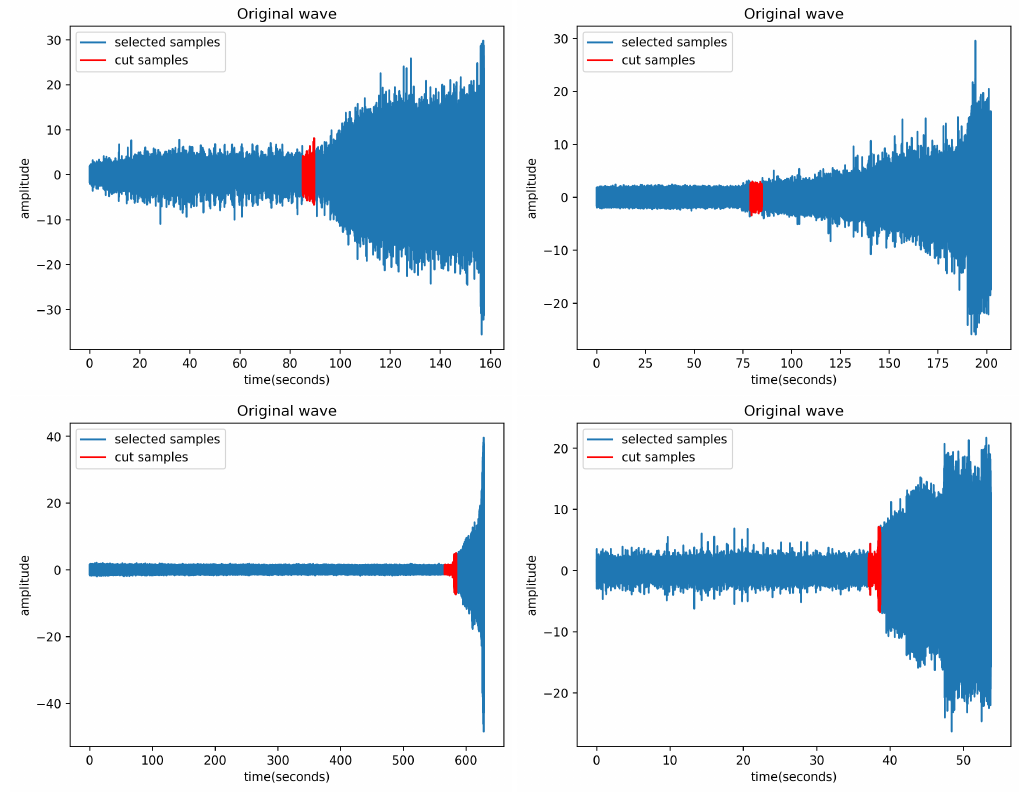
Figure 5. Samples of separating XJTU-SY phases.